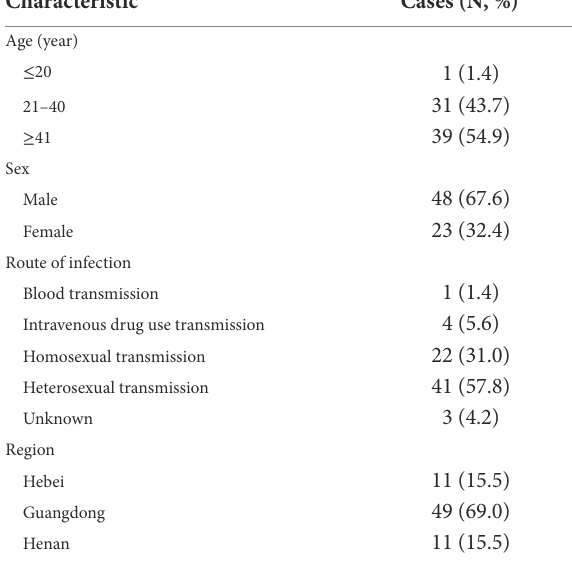
TABLE 2 Demographic and epidemiological characteristics of the patients.